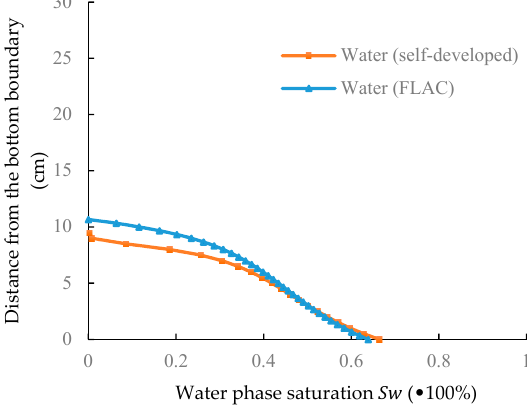
Figure 7. Simulated water-phase saturation distribution after 5000 s.